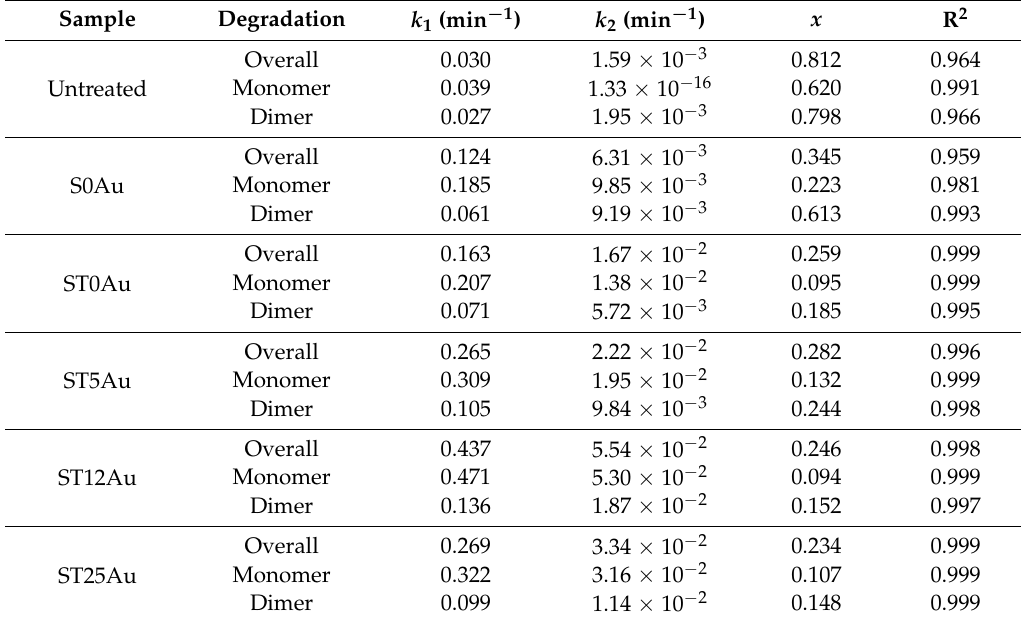
Table 4. Parameters of kinetic models calculated by the kinetic model proposed in this paper.